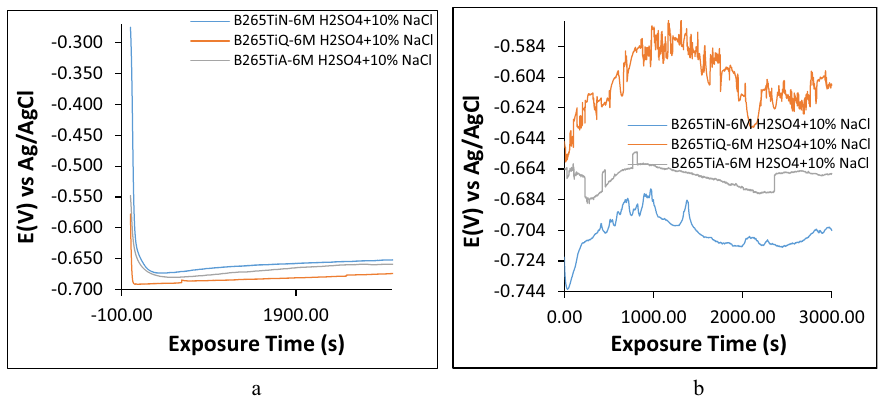
Figure 13: OCP plots of B265TiN, B265TiQ, and B265TiA alloy corrosion in 6 M H 2 SO 4 + 10% NaCl solution at ( a ) 30°C and ( b ) 70°C.